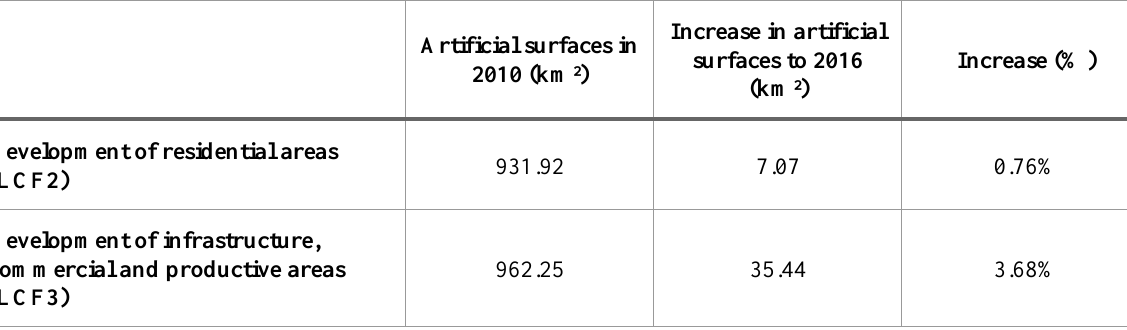
Table 1. Increase in artificial surfaces in the years 2010-2016 divided between growth for residential use and growth for productive and infrastructure